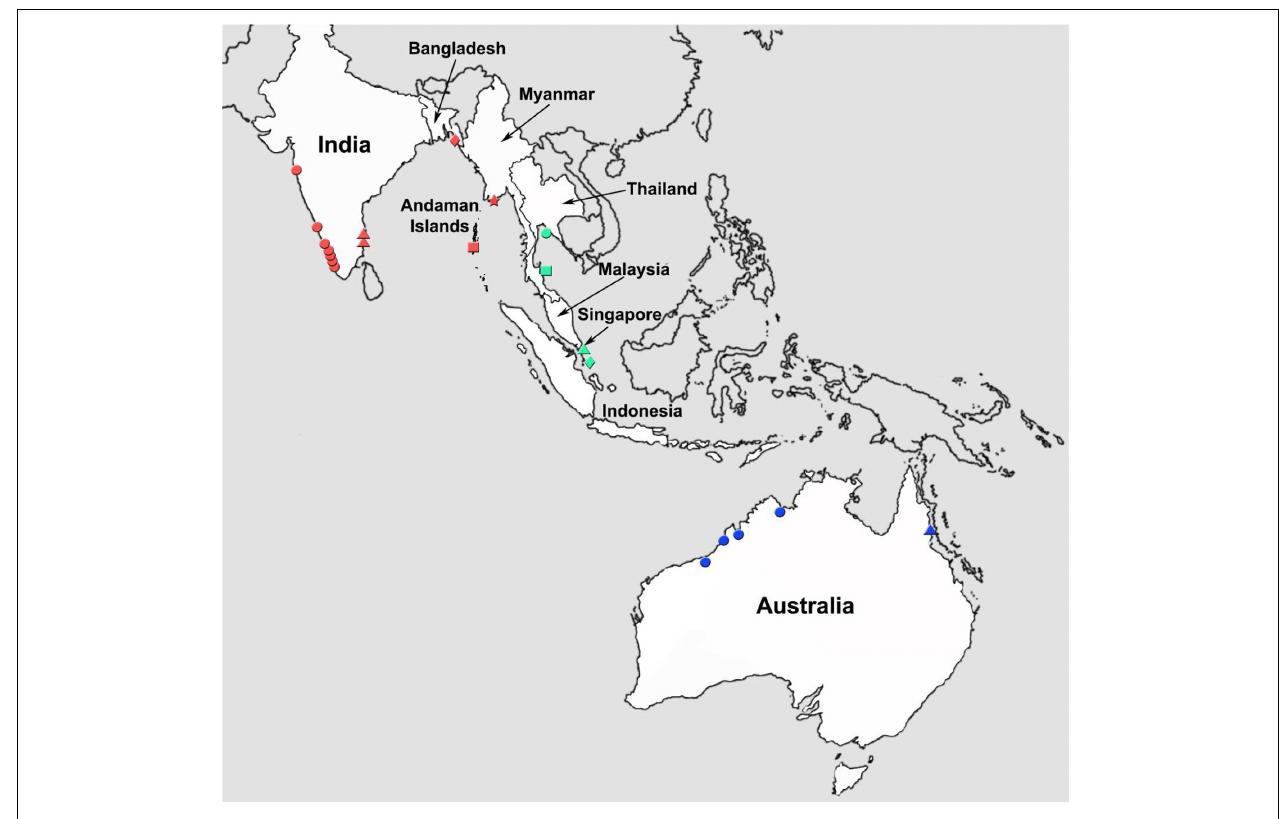
FIGURE 1 | Map of the tropical Indo-West Pacific region illustrating various locations from which Asian seabass were collected for this study. Locations: Western coastline of India (red circle); Eastern coastline of India (red triangle); Andaman and Nicobar Islands (red